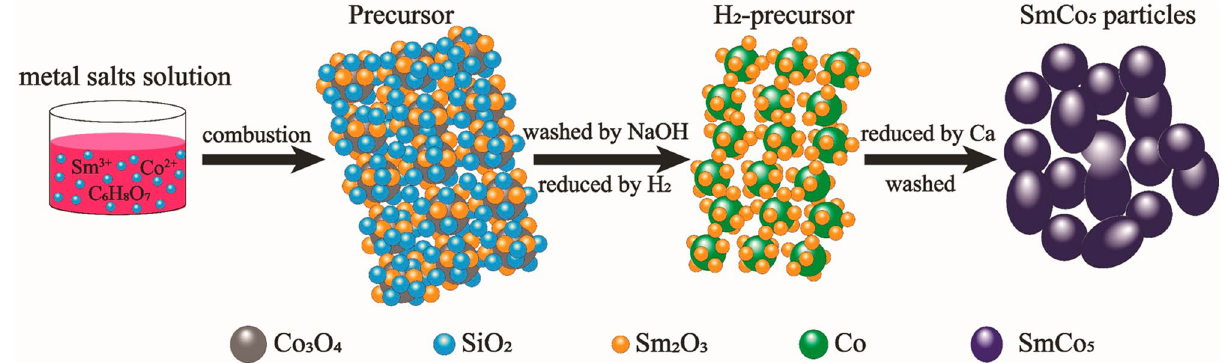
Figure 1. Schematic illustration of the synthesis of SmCo 5 particles from metal salts solution to the final product. Software: CorelDraw X6, www.corel draw.com.